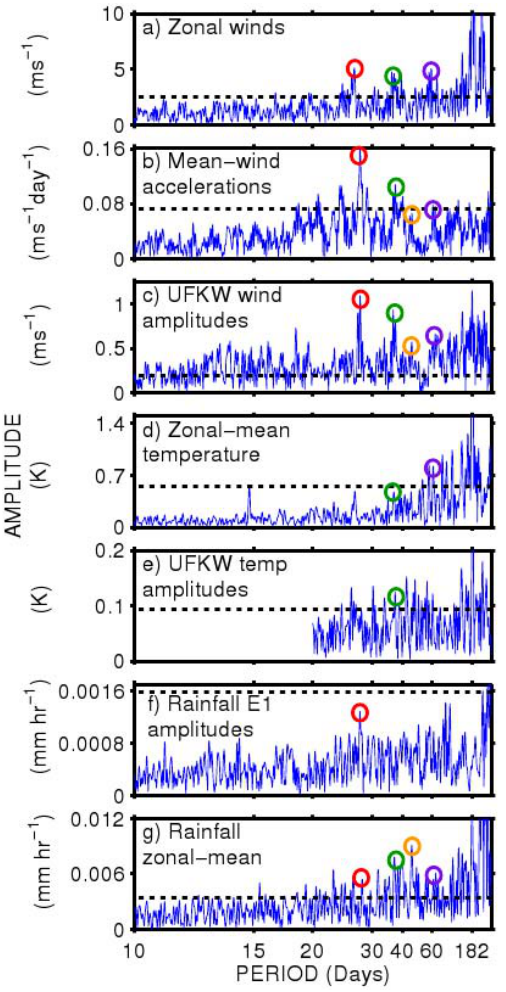
Fig. 20. Spectra of (a) zonal mean wind at a height of 87km, (b) mean-flow accelerations from UFKW derived from meteor radar zonal winds bandpassed in the 2.5–4.5 day range at a height of 83km, (c) UFKW wind amplitudes at a height of 81km, (d) zonal- mean temperature derived from Aura MLS observations, (e) UFKW temperature amplitudes at a height of 96km, (f) E1 2.5–4.5 day sig- natures in the TRMM rainfall rate and (g) zonal-mean rainfall rate magnitudes. A ten day window was used for the UFKW amplitudes in the MLS temperatures so (e) has been cut off at the Nyquist limit. The dashed horizontal lines represent the 95% confidence limits. Different colour circles are used to identify frequencies of interest in successive